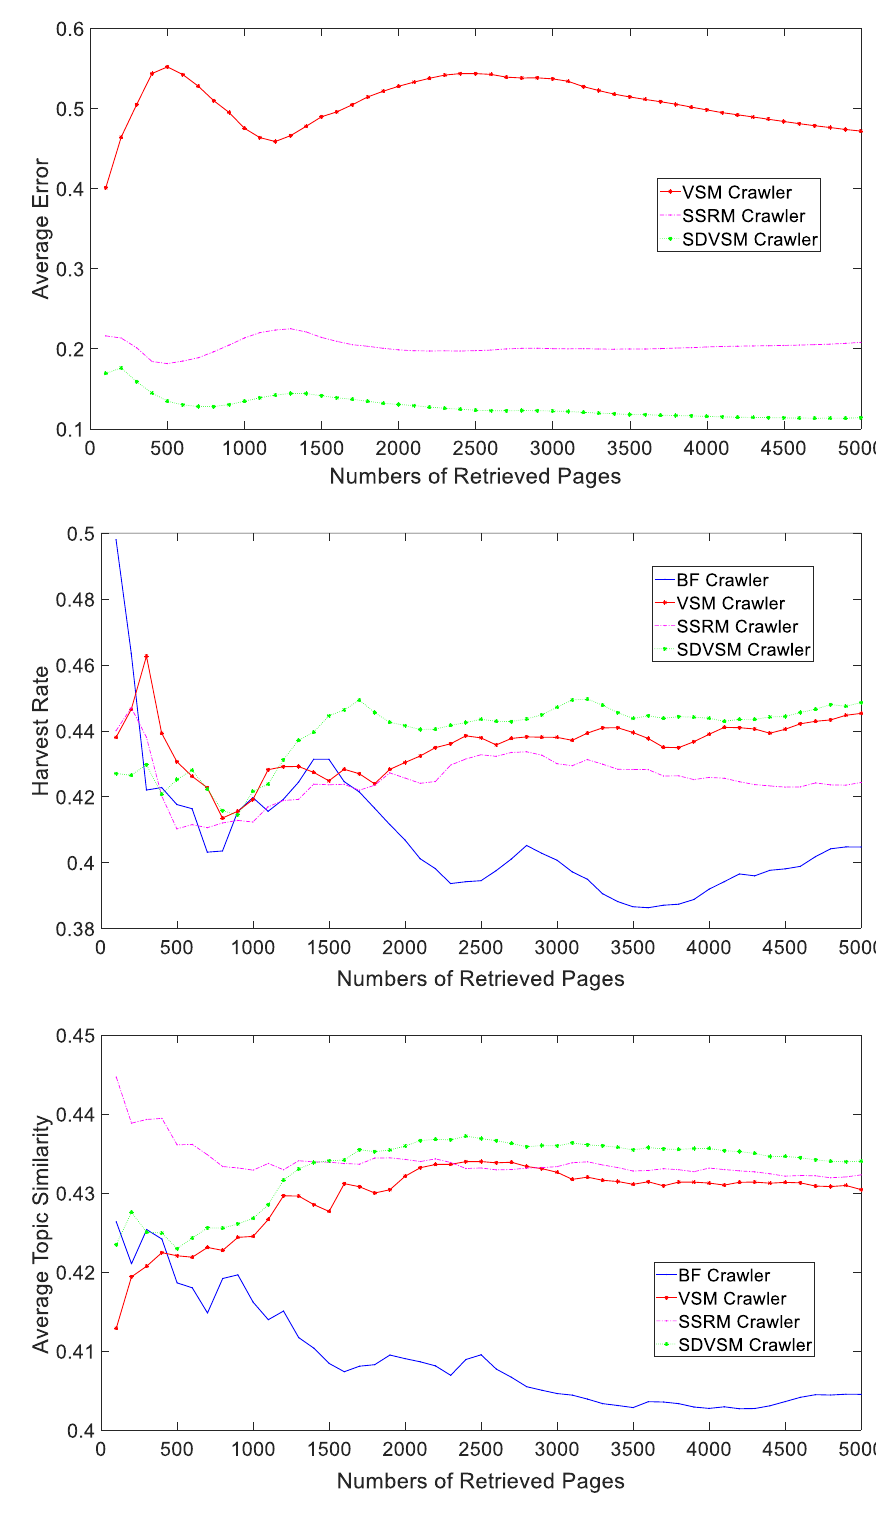
Fig. 12 The comparison of the average error for three focused crawlers based on the second group results